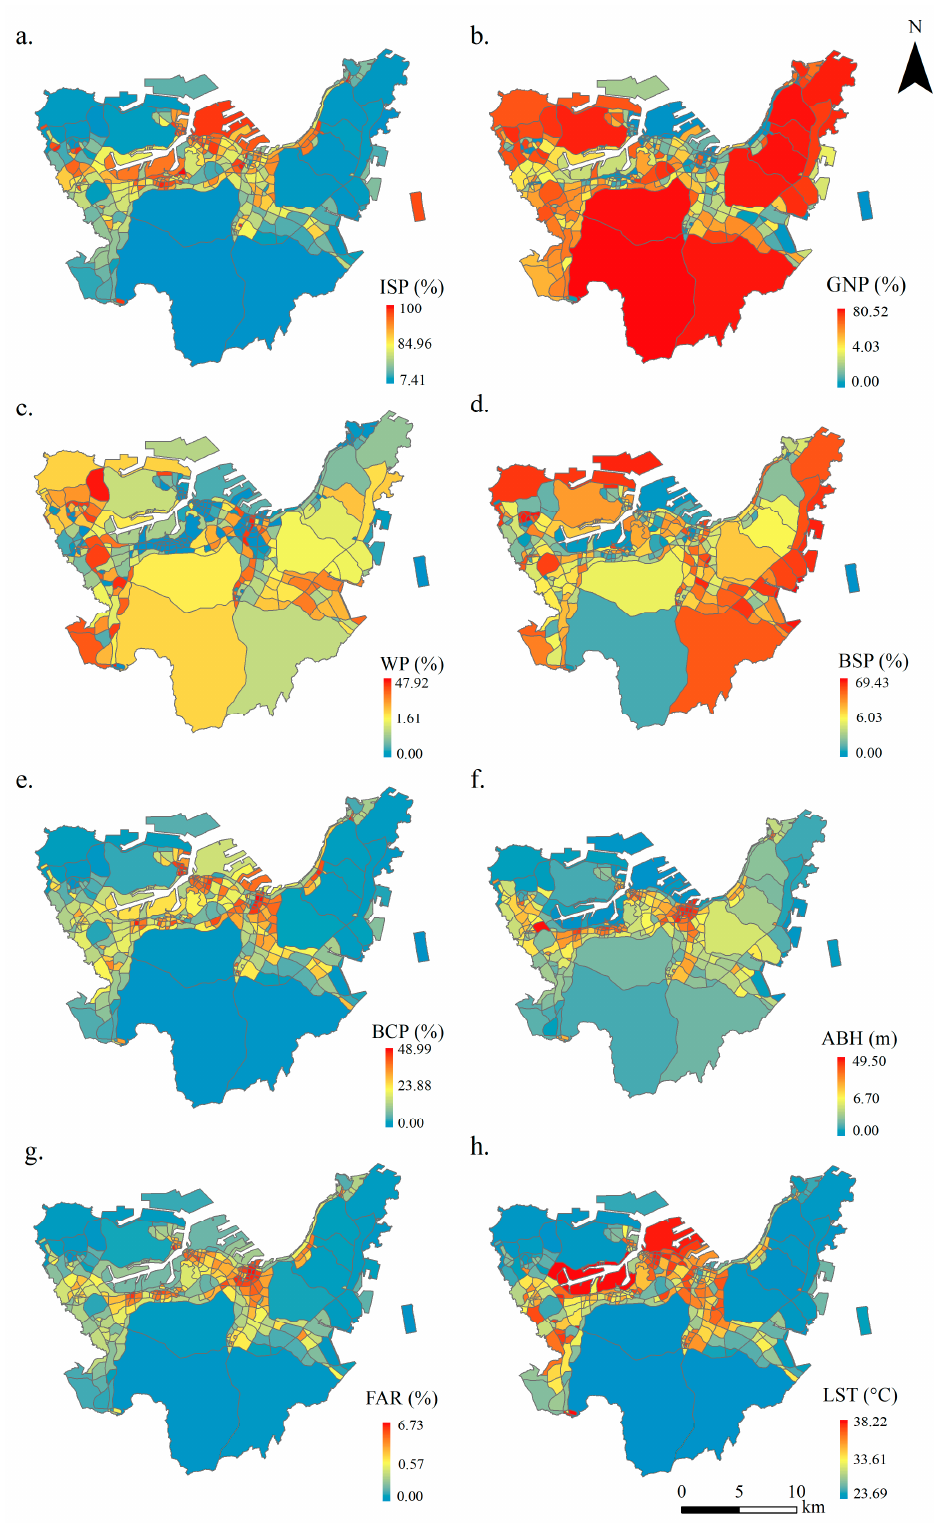
Figure 7. Block index spatial distribution of study area: ( a ) ISP; ( b ) GNP; ( c ) WP; ( d ) BSP; ( e ) BCP; ( f ) ABH; ( g ) FAR; ( h ) LST.